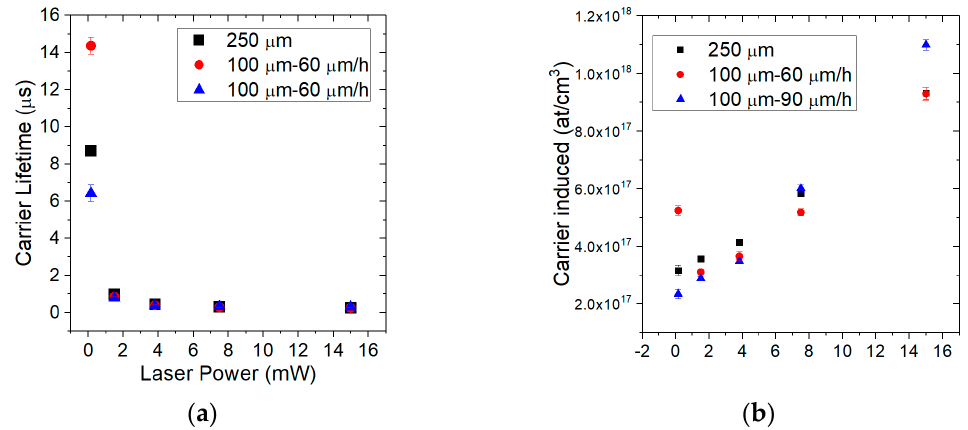
Figure 5. The figure shows the trends of the carrier lifetimes ( a ) and the amount of carrier induced ( b ) as a function of Raman shift and laser power for all samples analysed.